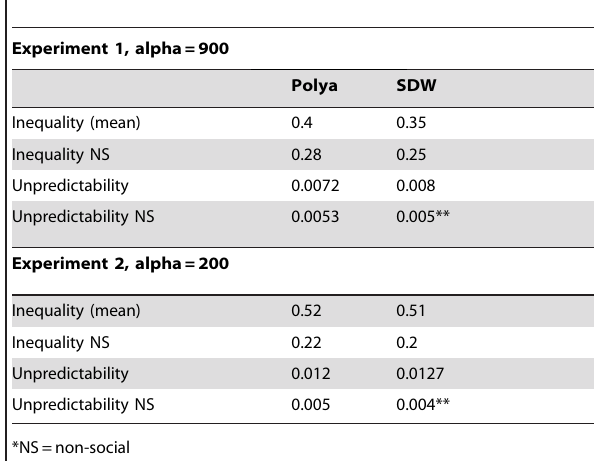
Table 1. Values of unpredictability and inequality from simulated (polya) and original (SDW)